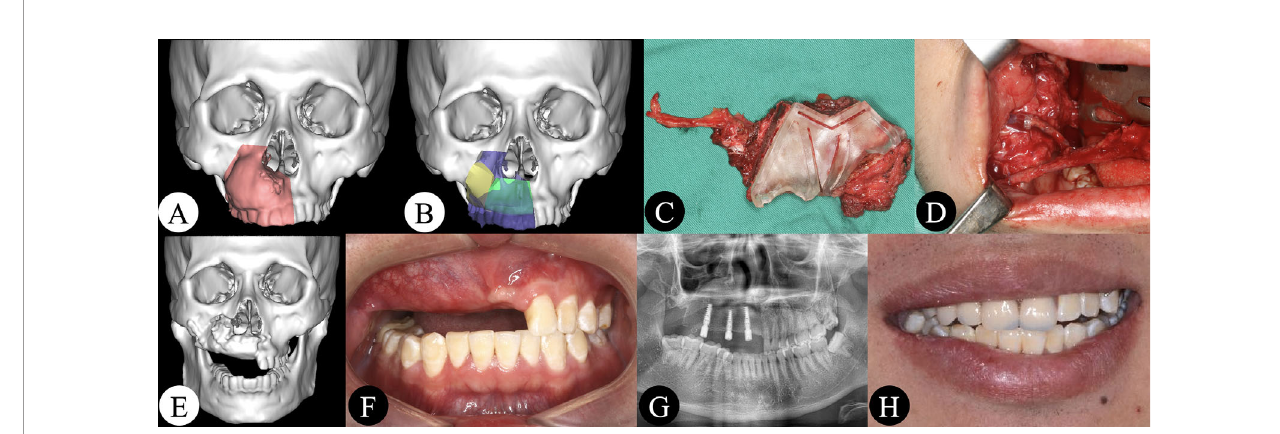
FIGURE 3 | (A, B) Maxillectomy and reconstruction were simulated using software. (C) DCIA fl ap harvesting and shaping under guidance of a three-dimensionally printed surgical guide. (D) Intraoral vascular anastomosis. (E, F) Postoperative CT scan and intraoral picture showing good bone contact and a good intermaxillary relationship. (G) Three dental implants were inserted. (H) An implant-based removable denture was